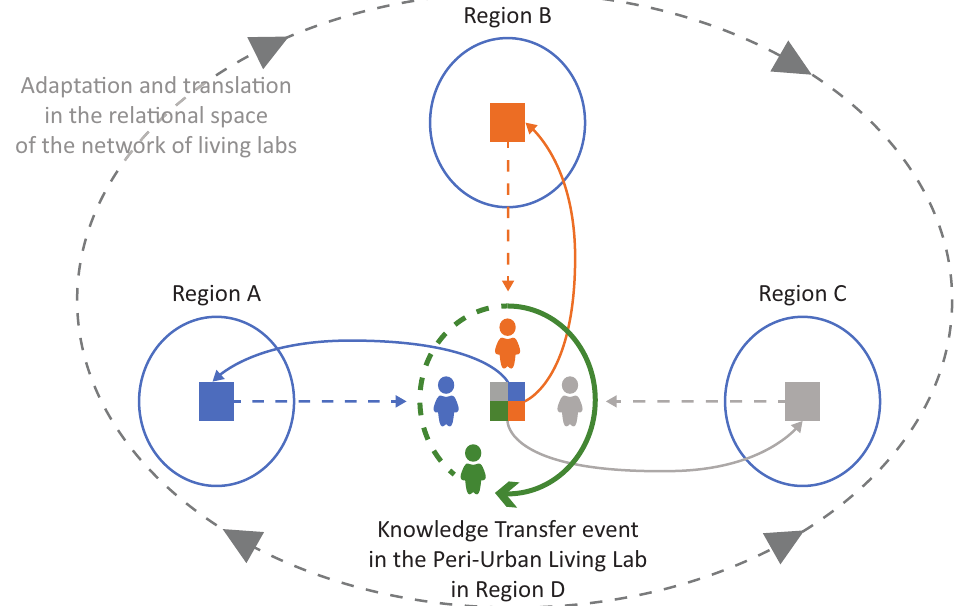
Figure 1. Co-creation and mobility of EIS in a network of living labs. Source: